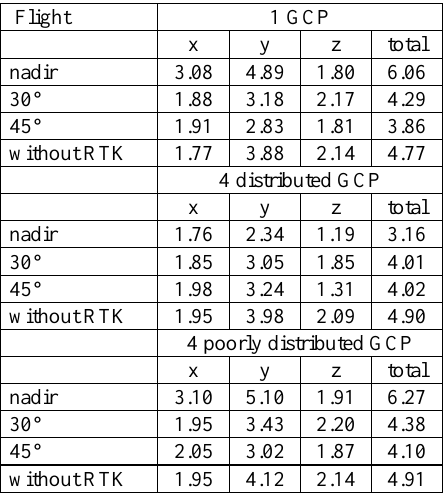
Table 3. Check point deviations [cm] for different GCP